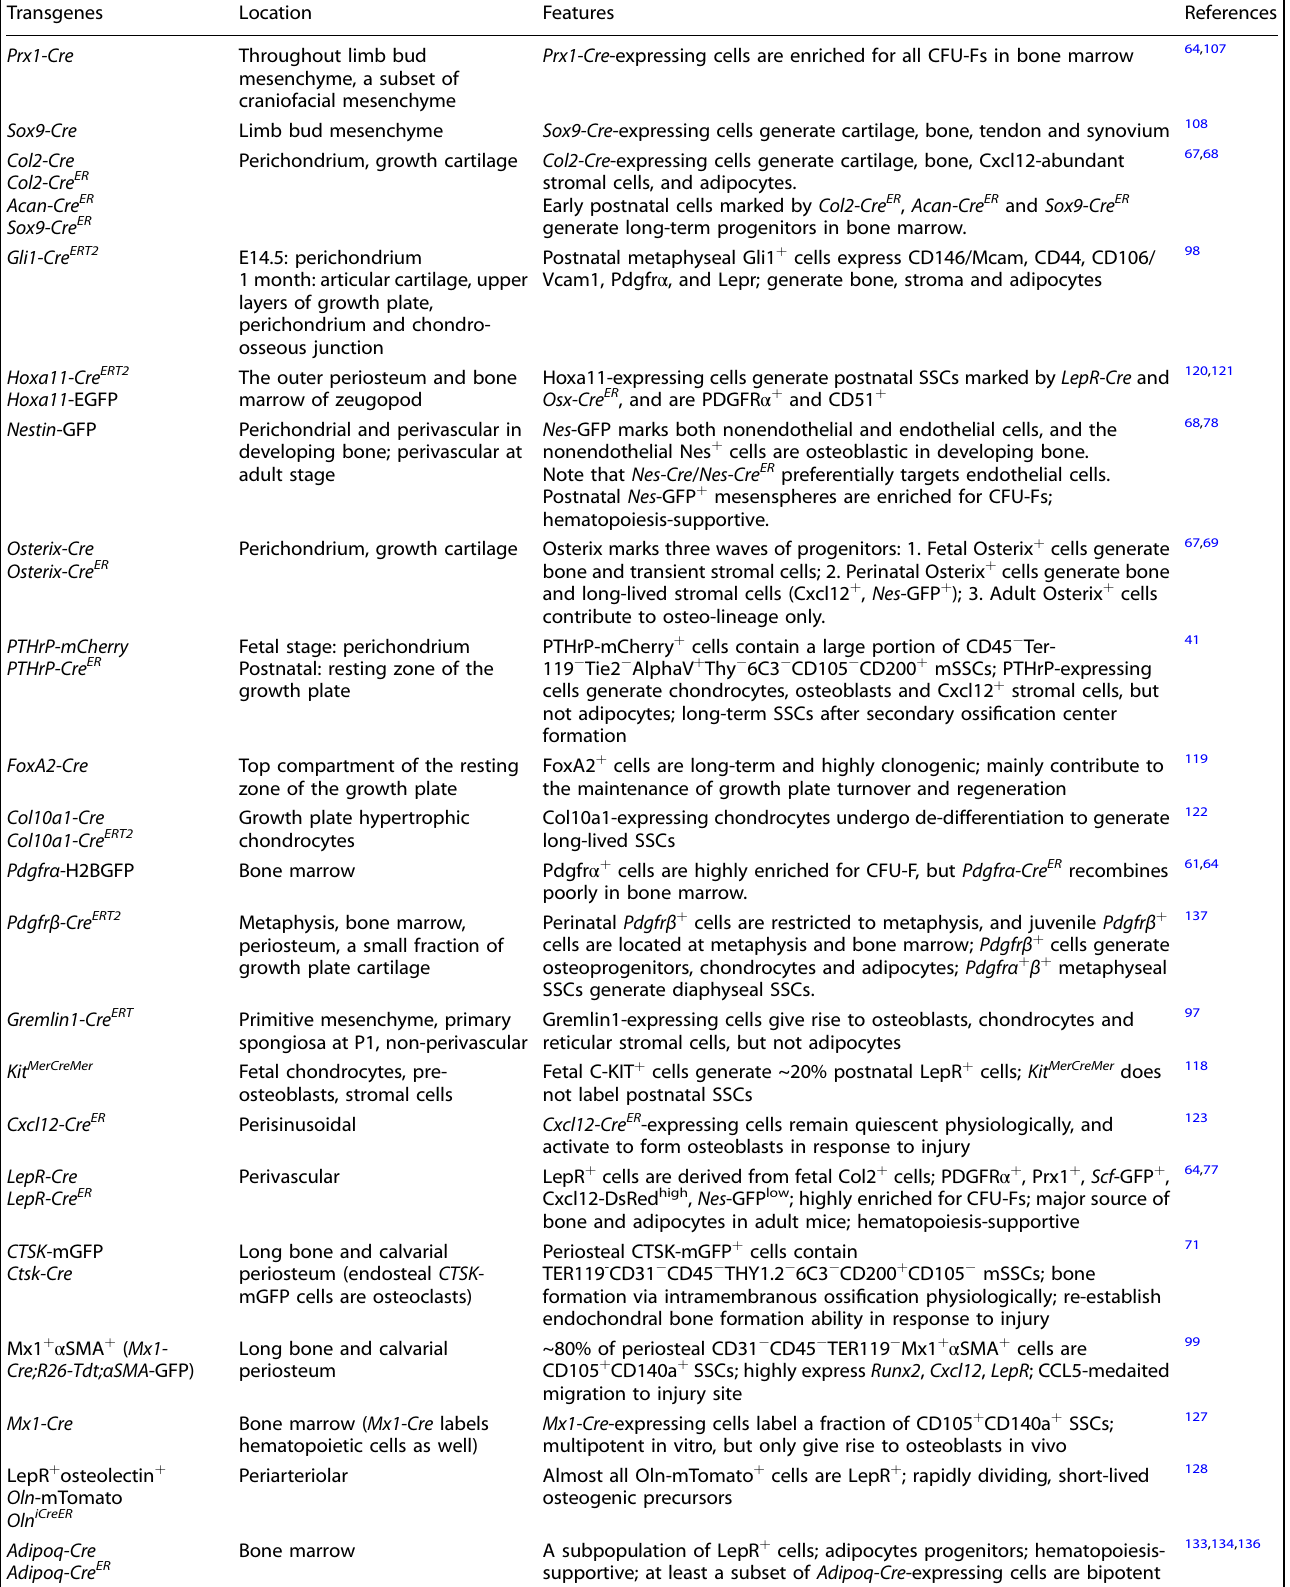
Table 4. Skeletal stem cells and progenitors labeled by transgenes Transgenes Location